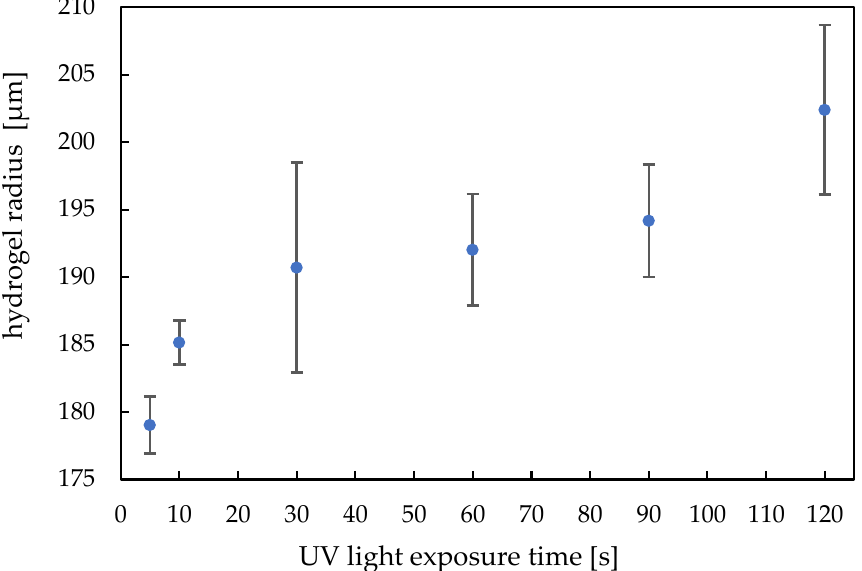
Figure 9. Dependence of the radius of hydrogels in dry state on the UV light exposure time (400 droplets, ca. 450 pl per drop).